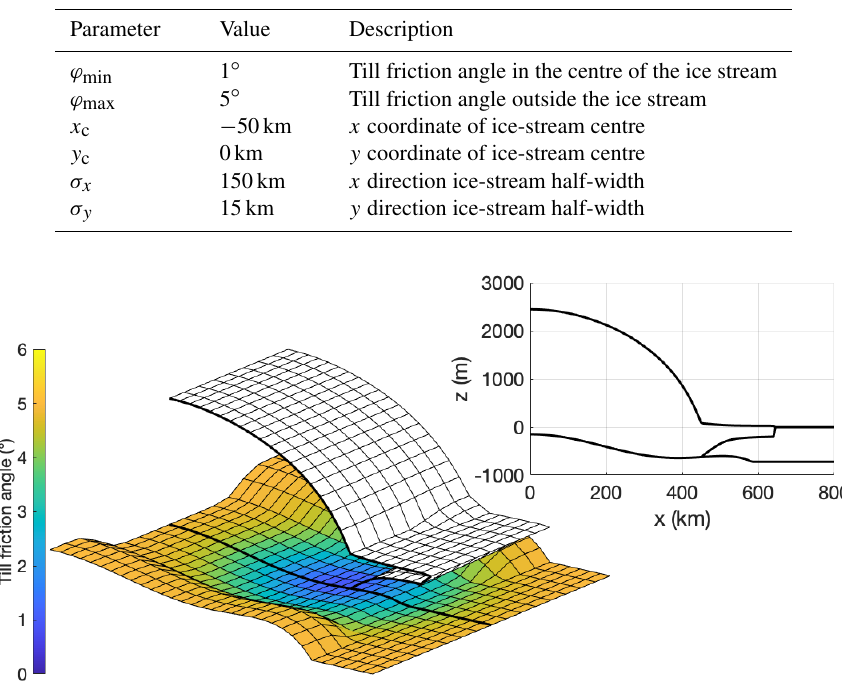
Table 2. Parameter values for experiment II.